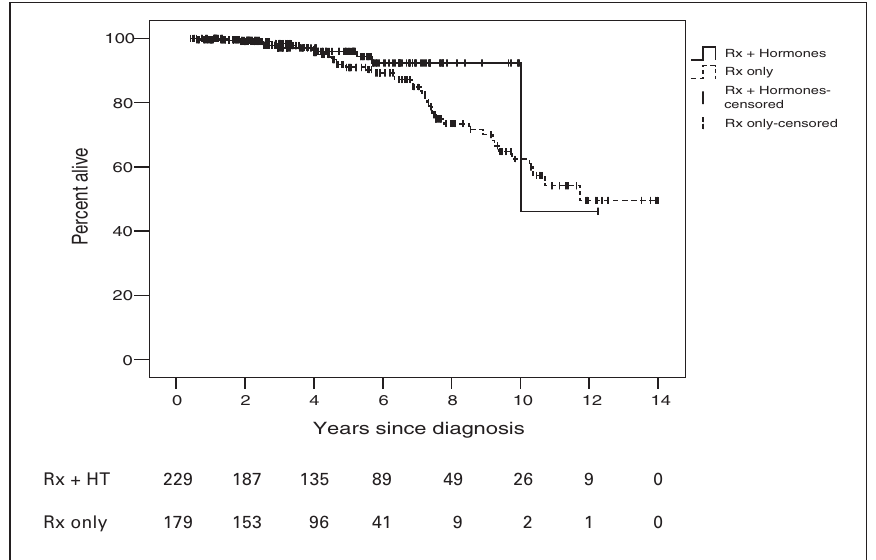
Cancer specific sur- vival (Kaplan-Meier, log-rank test) for the 229 patients treated by radiotherapy alone (Rx only) and for the 179 patients treated by neoadju- vant and concomitant androgen deprivation plus radiotherapy (Rx and Hormones). Pa- tients at risk at the start of each two-year period are also